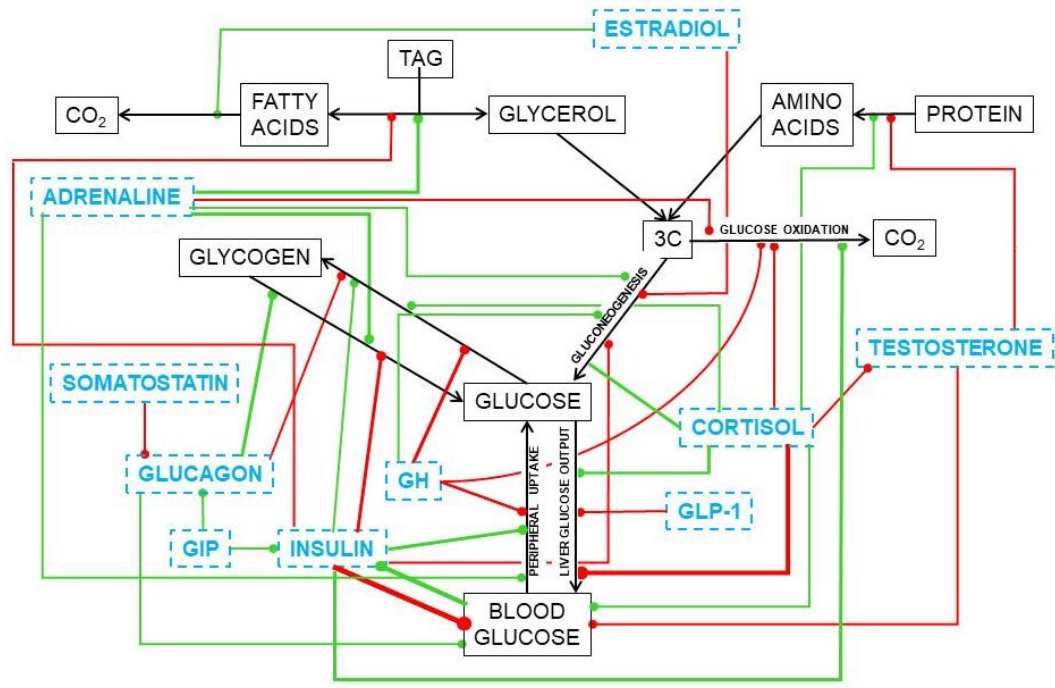
Figure 10. Simplified presentation of the main hormonal mechanisms that control the circulating concentrations of glucose. Black titles and arrows show the basic relationships between glucose and other substrates. Blue titles represent hormones and other regulating agents. Green lines indicate activation or increase effects of the regulator on the signaled path. Red lines show inhibitory or deactivation effects.